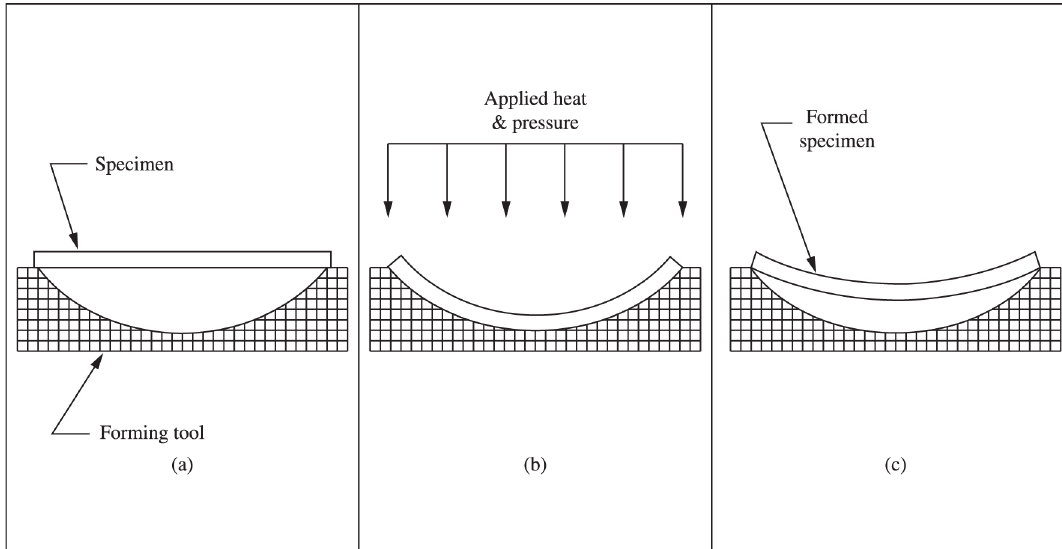
Figure 1. (a) Flat specimen prior to age forming; (b) Specimen reconfigured to assume radius; (c) Dimensionally stable, age formed specimen after experiencing springback 4 .